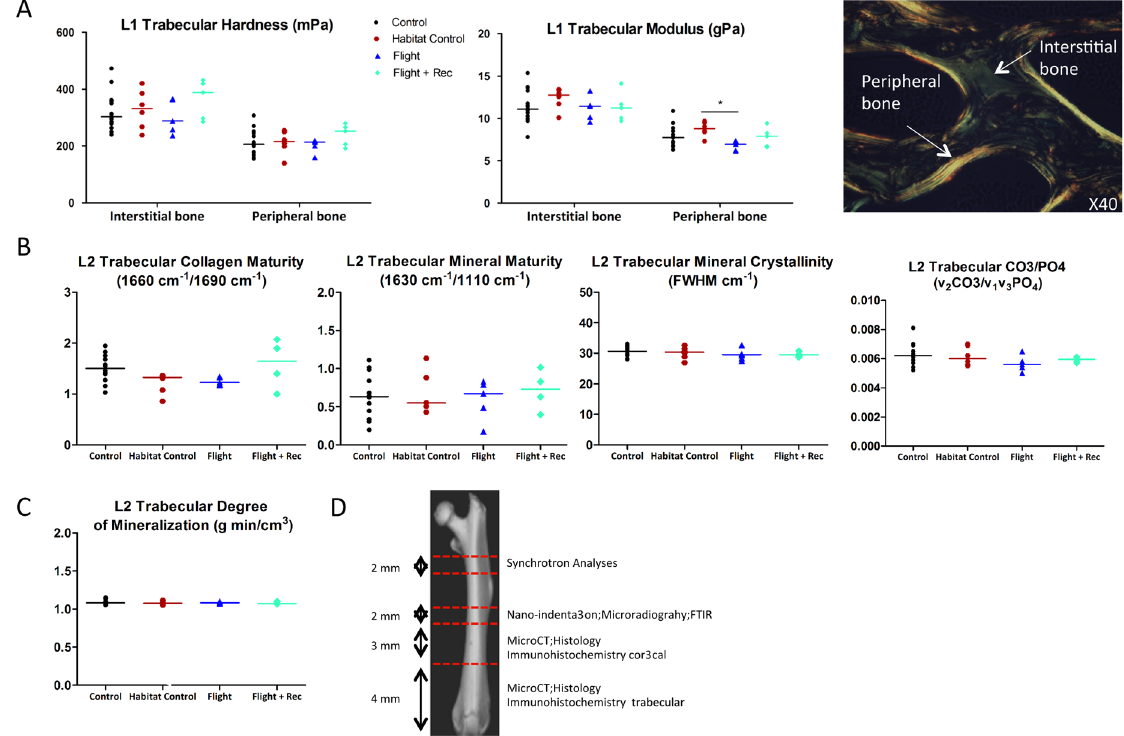
Figure 3. Effects of spacecraft housing conditions, spaceflight and recovery on ( A ) L1 vertebra biomechanical properties. The polarized light image on the right illustrates the two regions of interest for biomechanical analyses within vertebra trabeculae ( B ) L2 FTIRM parameters and ( C ) L2 DMB. Data are presented as clusters of individual points (bars = median). * p < 0.017, ** p < 0.003. ( D ) Representative schema of the investigated zones in